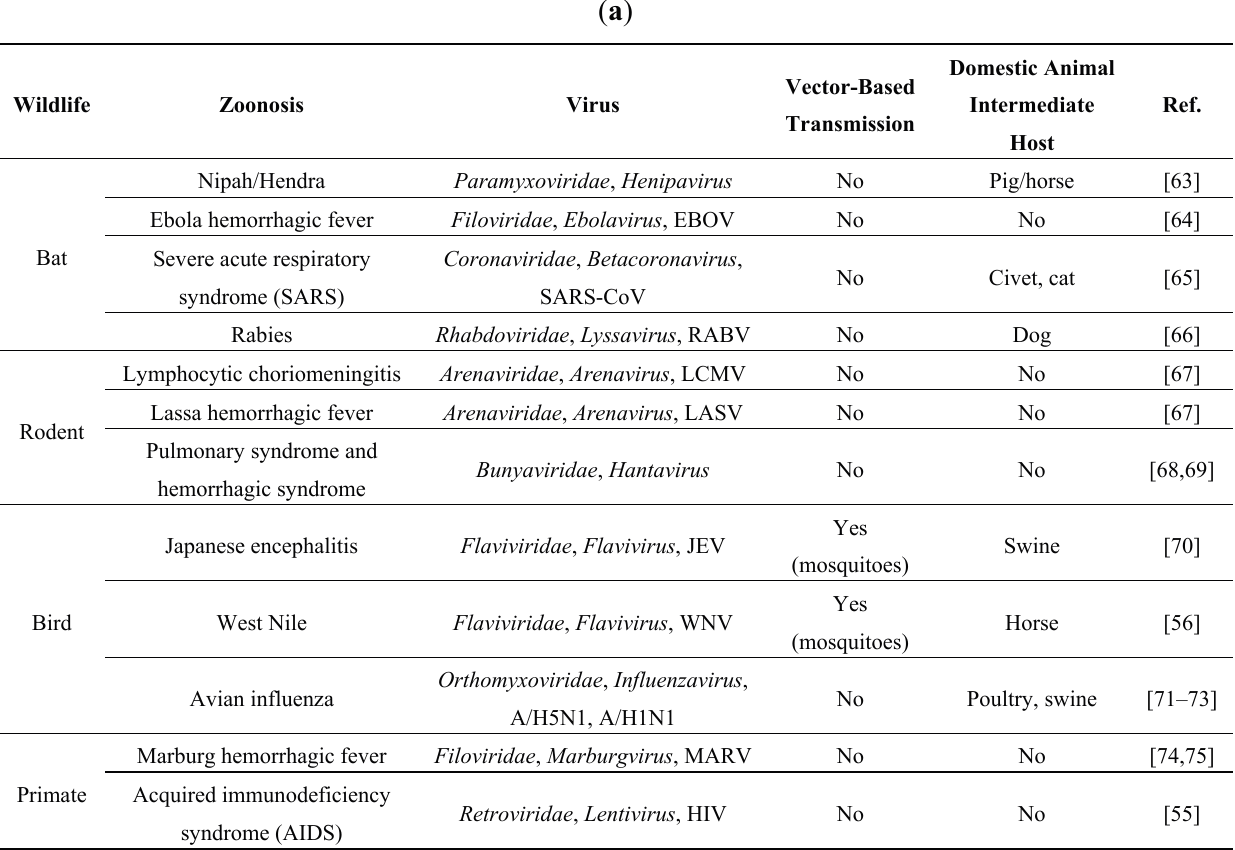
Table 2. ( a ) Non-exhaustive list of major zoonotic viruses detected in wildlife; ( b ) Examples of viruses detected in bats and rodents by metagenomic